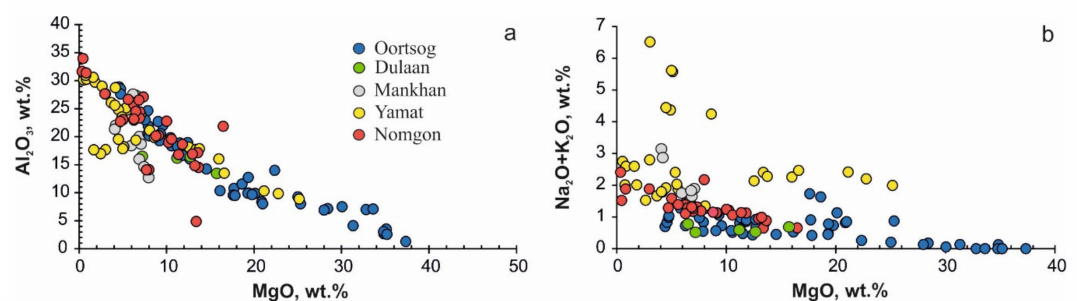
Figure 3. MgO vs. Al 2 O 3 . ( a ) (Na 2 O + K 2 O); ( b ) of mafic-ultramafic rocks of the Khangai